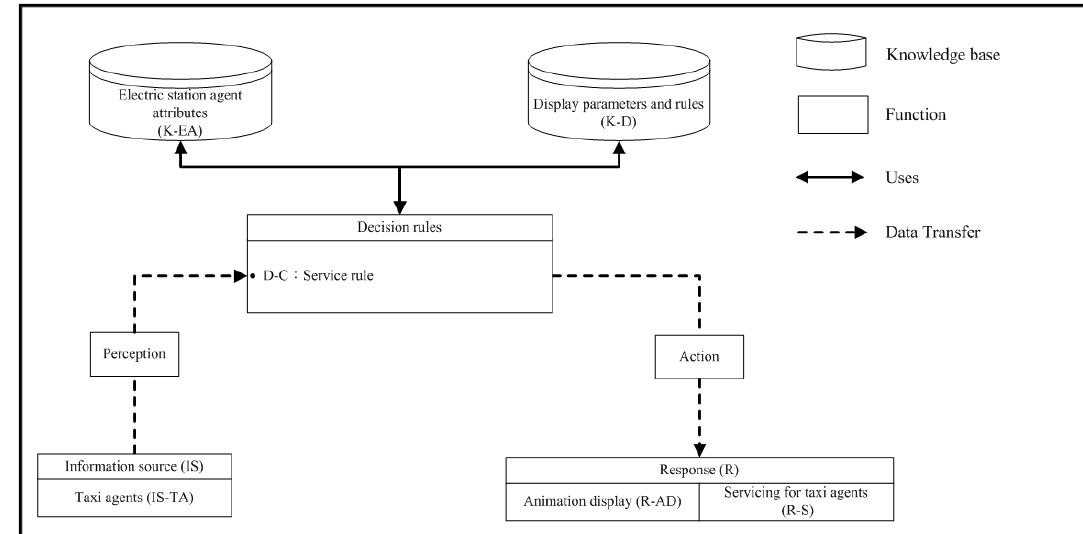
Figure 5. “The framework of Electric-taxi agent”.